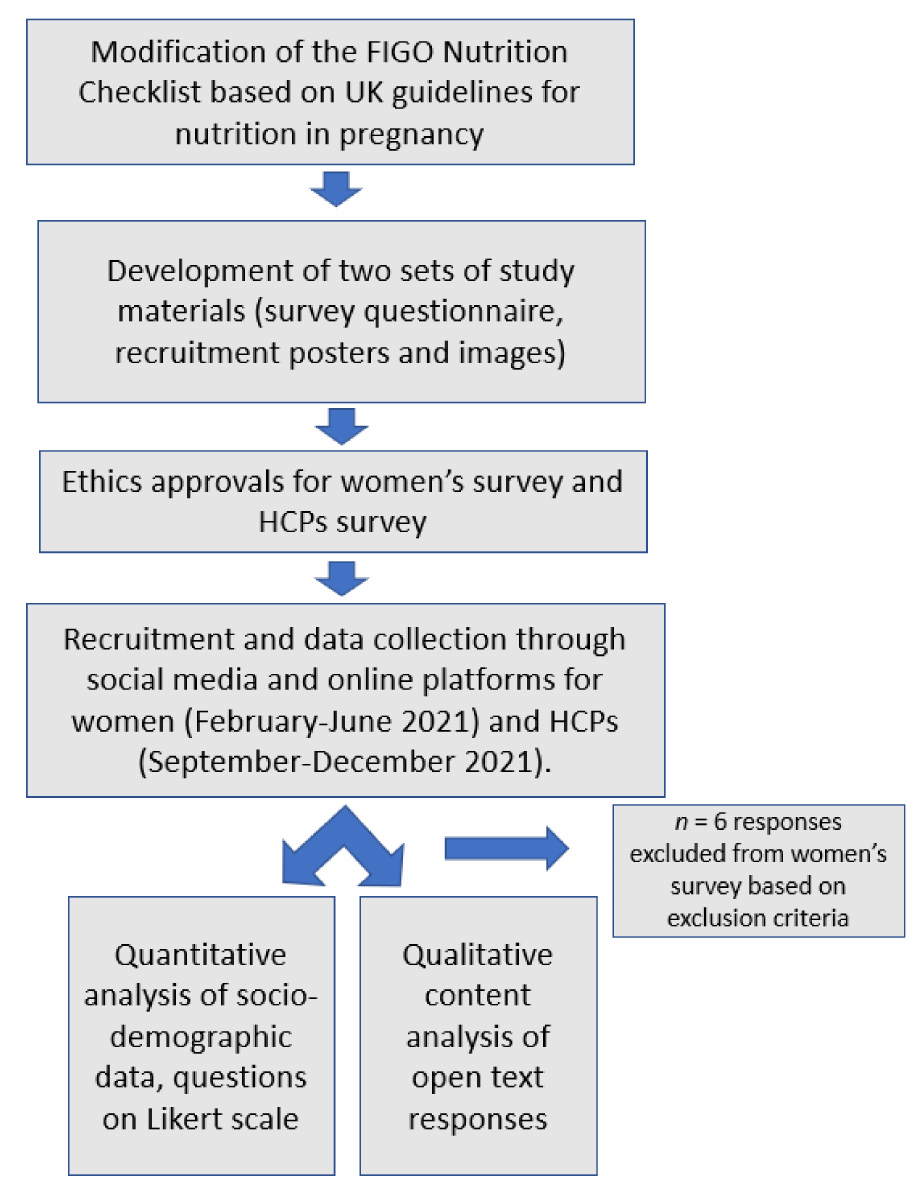
Figure 1. Flowchart for study process. FIGO, International Federation of Gynecology and Obstetrics; HCPs, healthcare